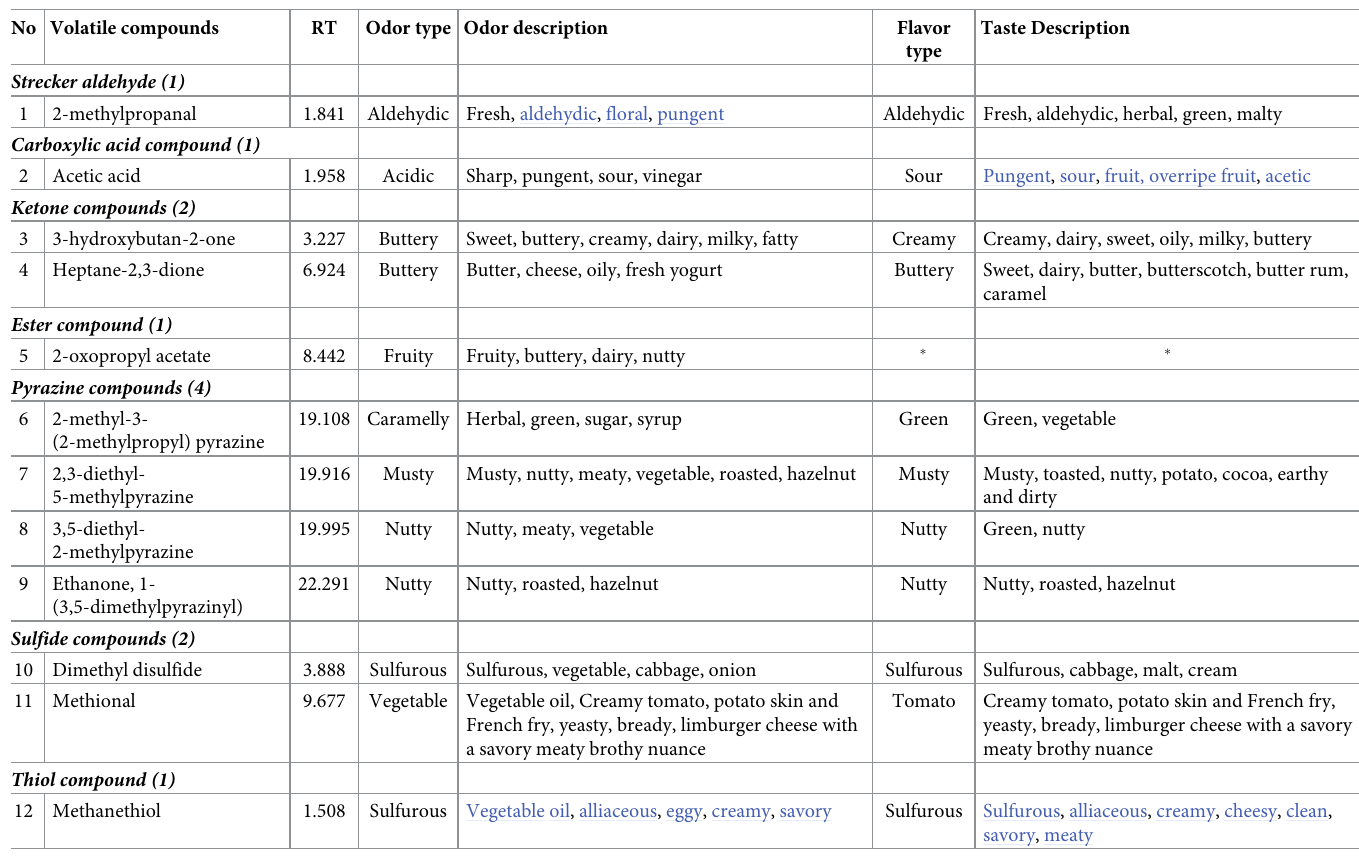
Table 4. Volatile compounds, odor, and taste description of process flavorings extruded from methionine: dextrose: modified starch: water at the ratio of 56:14:25:5. No Volatile compounds